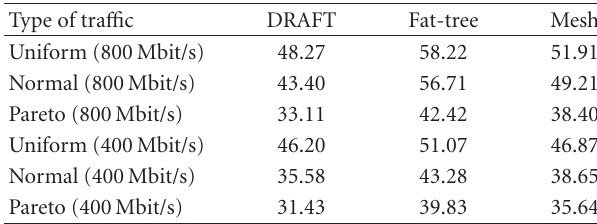
Table 2: Influence of the di ff erent data tra ffi cs over the latency (average clock